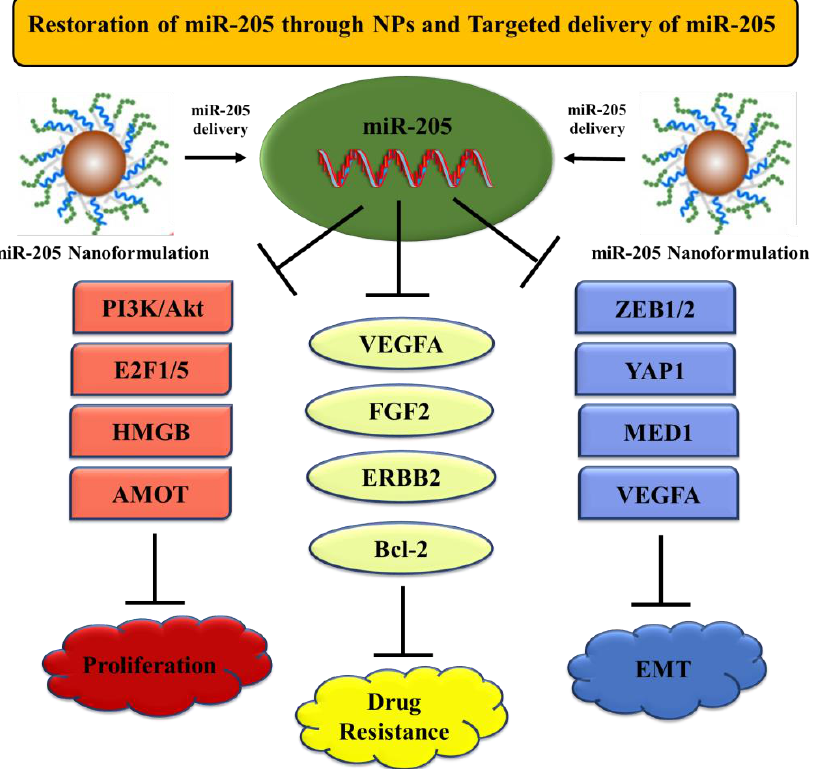
Figure 5. Schematic diagram showing restoration of miR-205 through nanoparticles. Delivery of miR-205 with nanoformulations can lead to an enhanced tumor suppressive role of miR-205 in cancer via targeting several signaling pathways/genes.